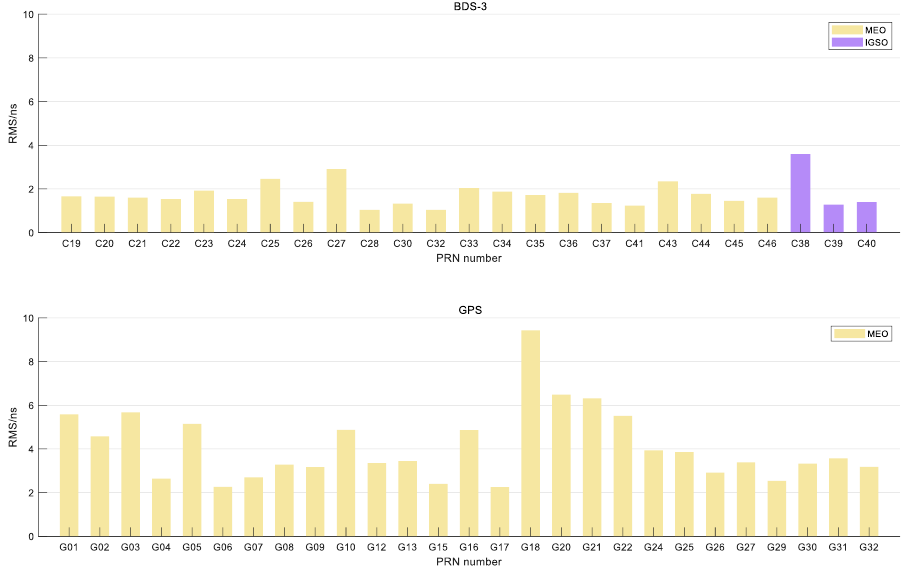
Figure 8. RMSE of the BDS-3 and GPS satellite clock offset recovered with the PPP-B2b signals using the GBM orbit products as a reference during DOY 168–198 in 2022.